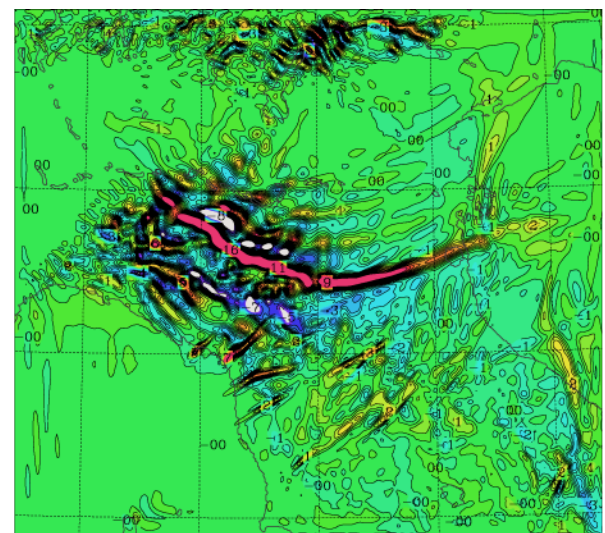
Fig. 2. 500 hPa analysis (height and temperature) at 12:00 UTC 30 October 2008. Modified from NWS DIFAX Weather Map Archive at http://archive.atmos.colostate.edu/.